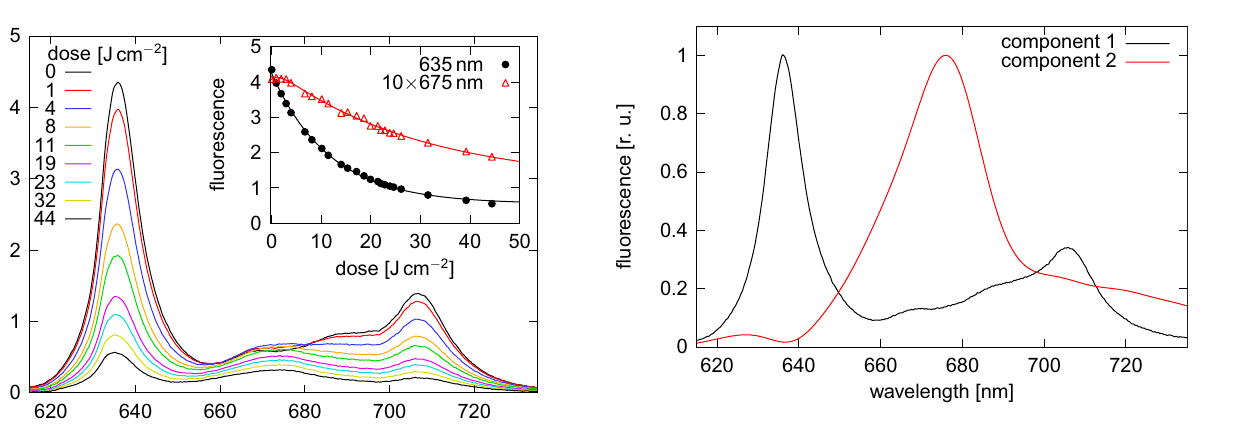
Fig. 4. Two main principal components obtained by singular decomposition of set of decaying °uorescence spectra at one selected spot in scar of an animal treated by Metvix. The component 1 corresponds well to °uorescence spectrum of pure PpIX, the component 2 may be ascribed to emission spectrum of the photoproducts.